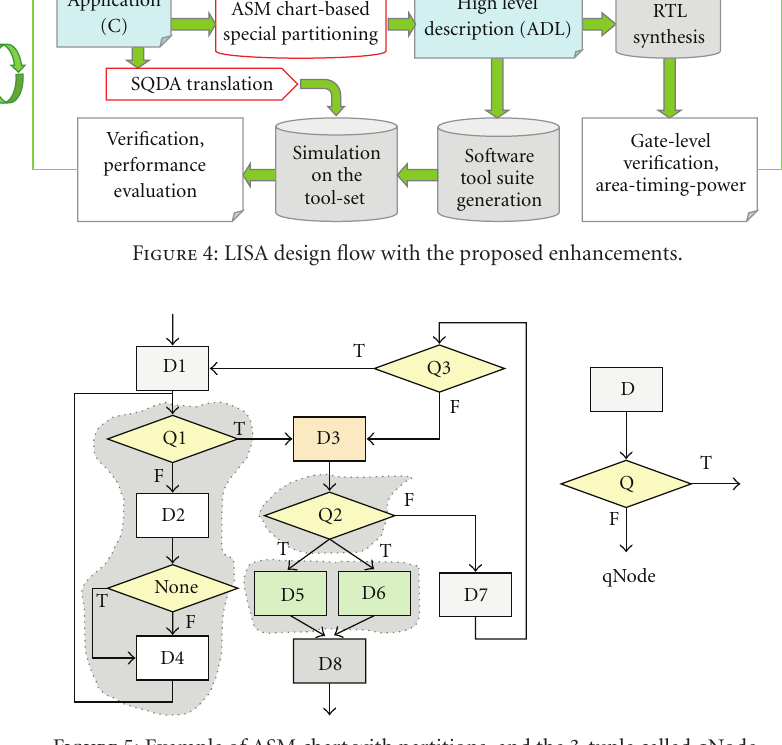
Figure 5: Example of ASM chart with partitions, and the 3-tuple called